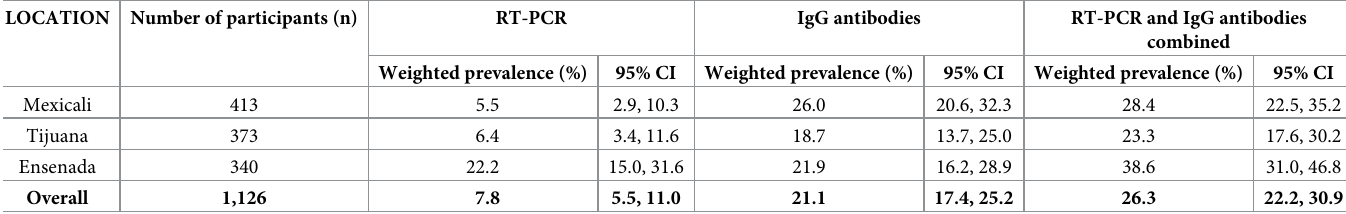
Table 4. Prevalence of SARS-CoV-2